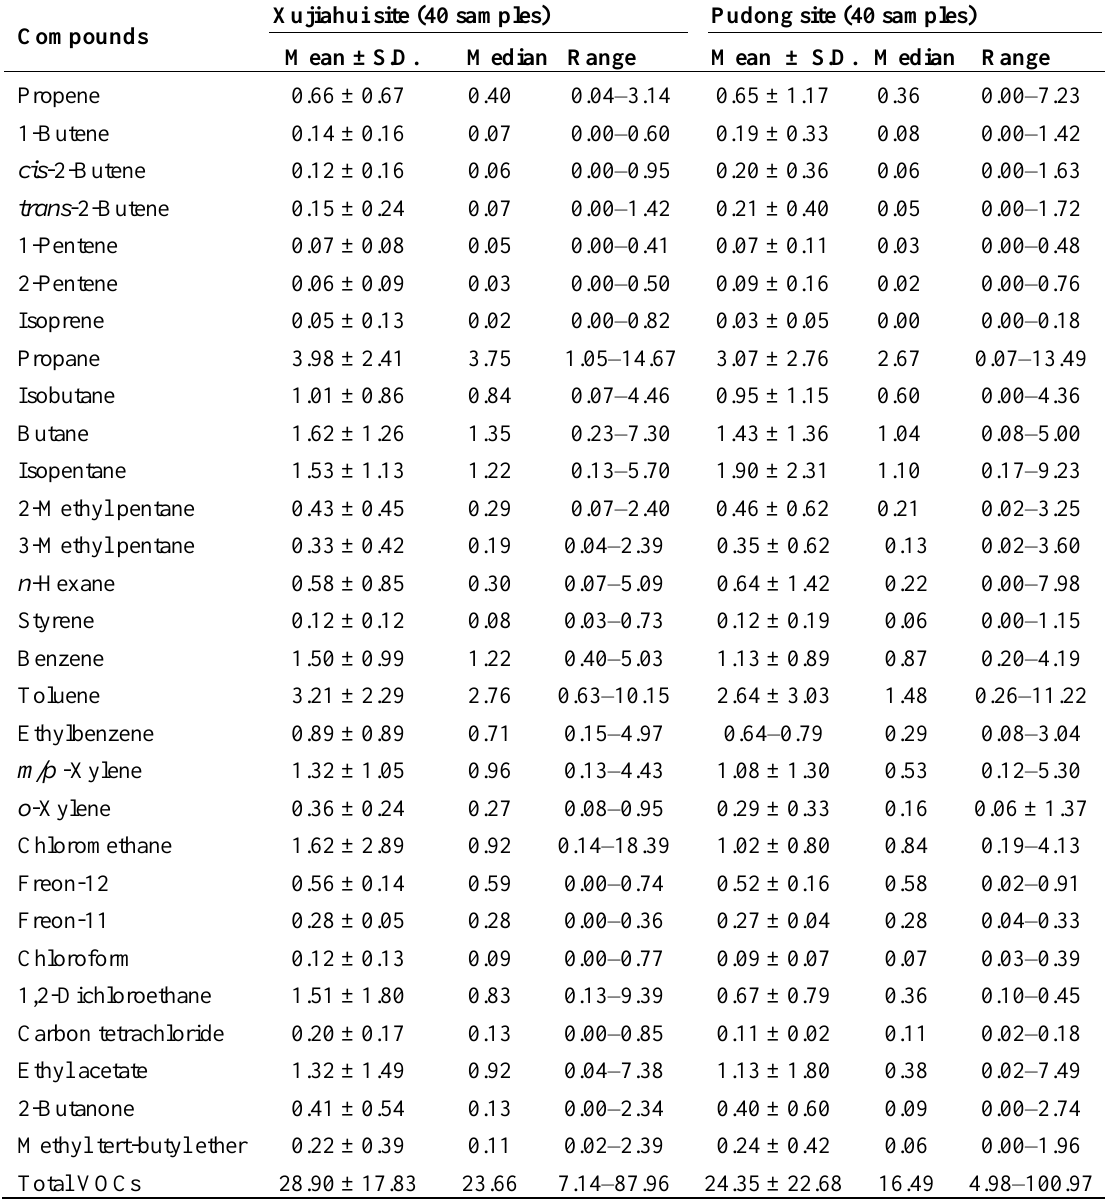
Table 2. Measured VOC concentrations (ppbv) at the Xujiahui and Pudong sampling sites (sampling period: